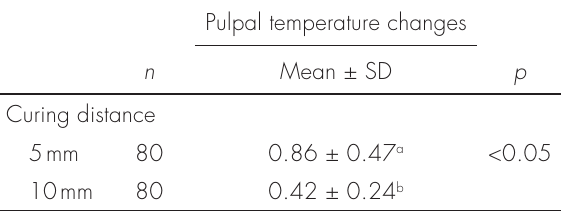
Table III. Pulpal temperature changes relative to curing distance and statistical comparison.